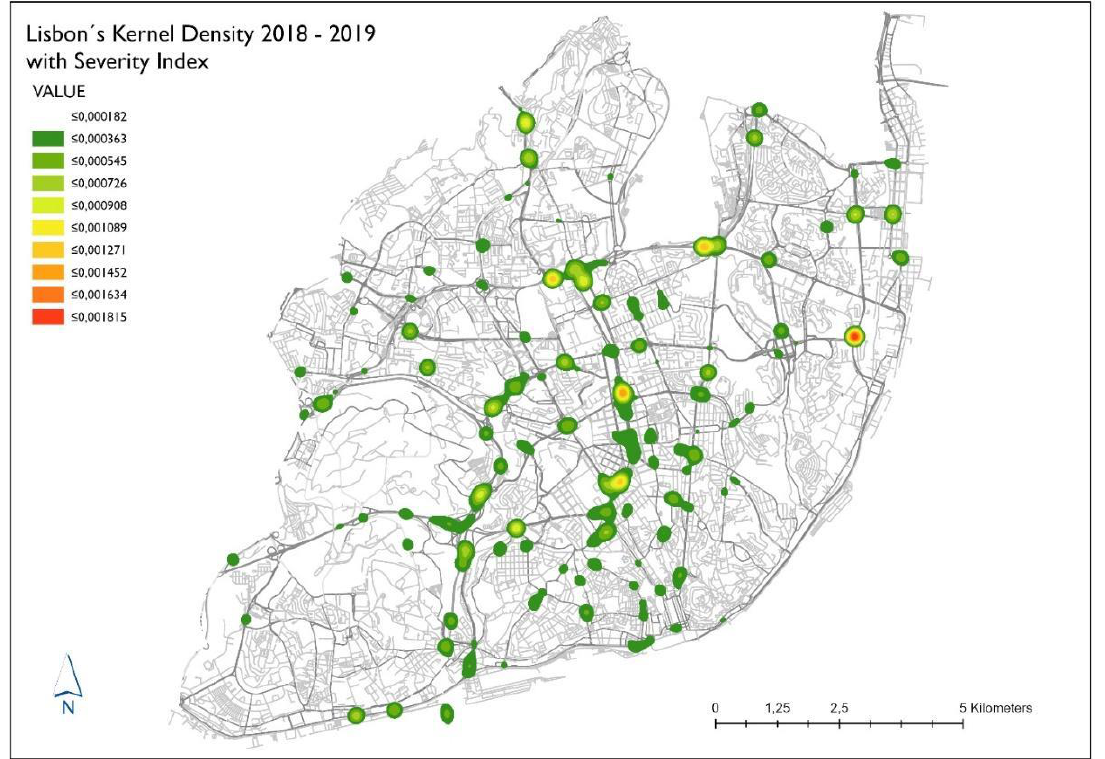
Figure 4. KDE analysis Biennial analysis 2018 – 2019.